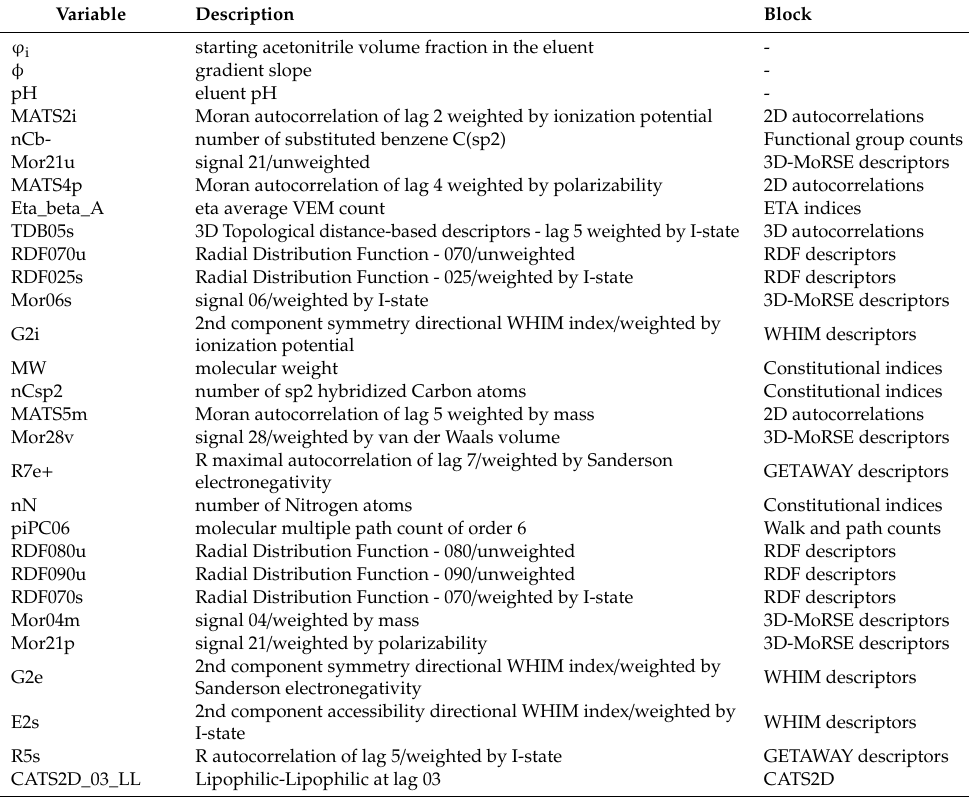
Table 2. List of the 29 predictors selected by the GA in order of decreasing